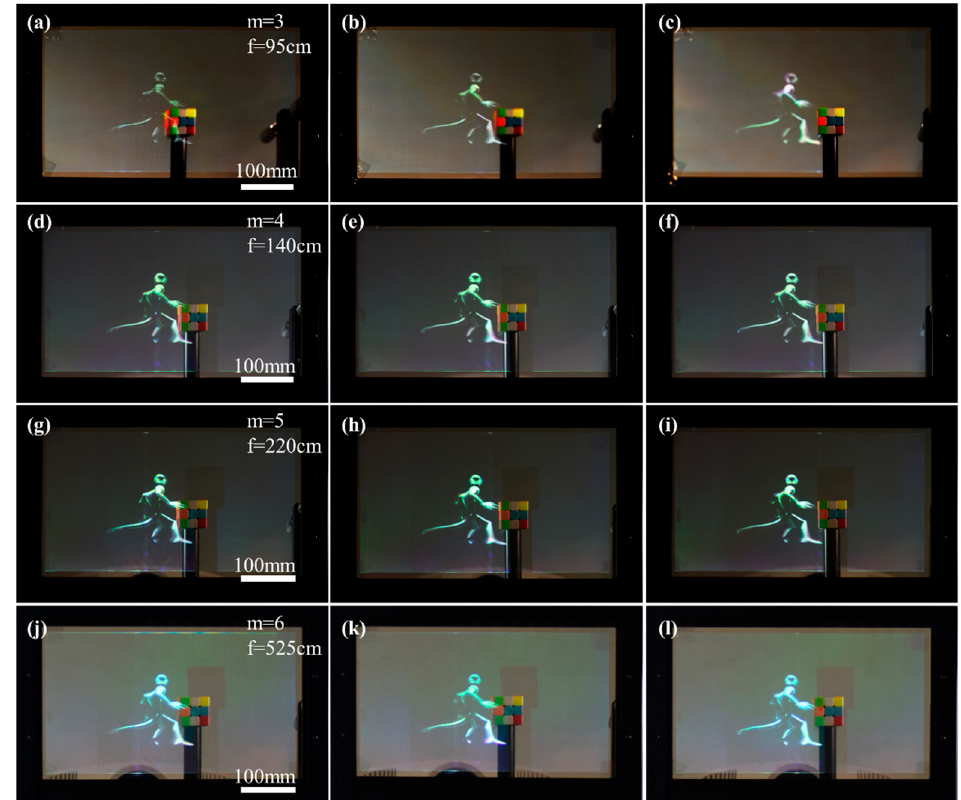
Figure 4. Virtual 3D dinosaur and a physical Rubik’s cube captured from left, middle, and right views at a viewing distance of 95 ( a – c ), 140 ( d – f ), 220 ( g – i ), and 525 cm ( j – l ), respectively. The f and m in the figure represent the viewing distance and the diffraction order, respectively. The f/#, and exposure time of the camera are 50/2.2, and 1/100 s, respectively.